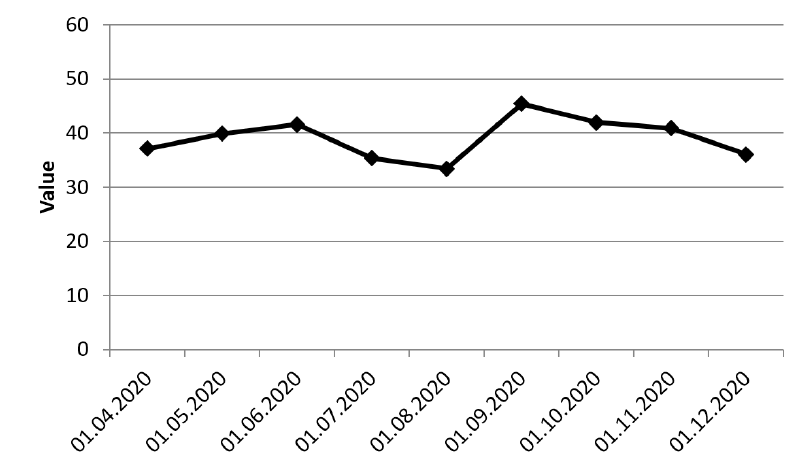
Figure 3. Time series of equipment operating time percentage. Table 1. Time series of equipment operating time percentage. Monthly Time Point Working Hours According to the Program,